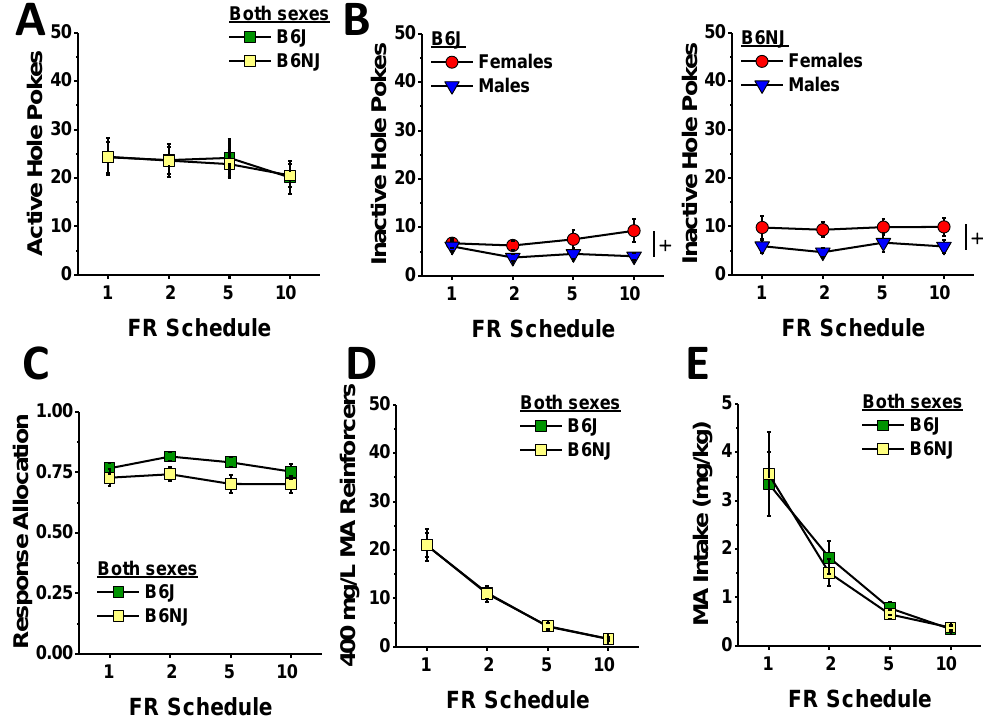
Figure 4. Summary of the substrain and sex differences in MA reinforcement during the demand- response phase of the study, highlighting the small or no group difference in the number of nose pokes into the active, MA-reinforced hole ( A ) and the inactive, non-reinforced hole ( B ) in B6J (left) and B6NJ mice (right) as well as the ratio of responses made in the active vs. inactive hole ( C ), number of reinforcers earned ( D ), and the MA intake ( E ) across the increasing response ratios. The data represent the mean ± SEM of 12 mice/sex/substrain. + represents a significant sex effect, p < 0.05. Given that the mice failed to adjust the number of nose pokes in response to the increasing response requirement, the number of MA reinforcers earned dropped precip- itously with the increasing response requirement (schedule effect: F (3,120) = 101.1, p <